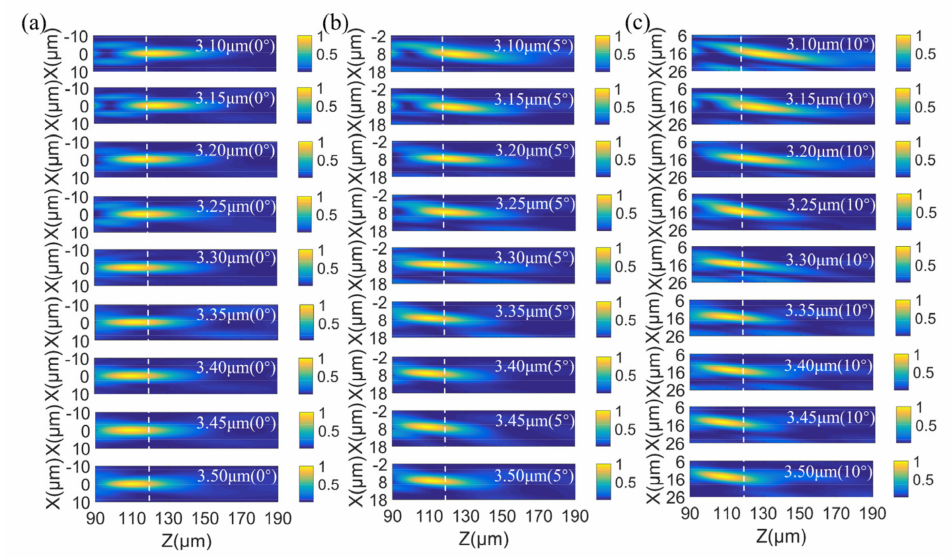
Figure 7. Focusing performance of the doublet metalens. Simulated intensity profiles in the xz-plane at wavelengths from 3.1 to 3.5 µ m, with incident angles of 0 ◦ ( a ), 5 ◦ ( b ), and 10 ◦ ( c ),